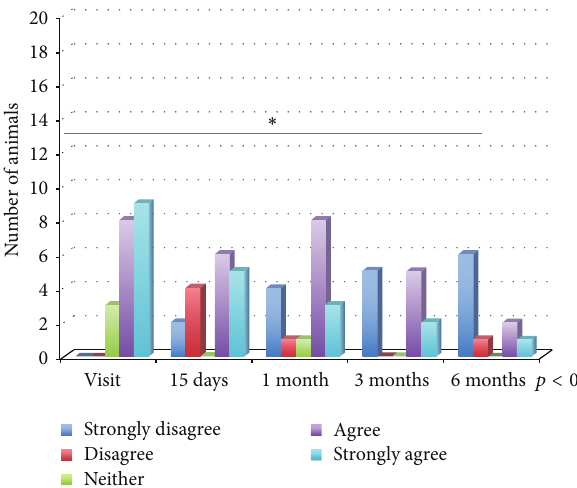
Figure1:Behaviouralmedicine:“Iamconcernedaboutthedisorder of my animal.”